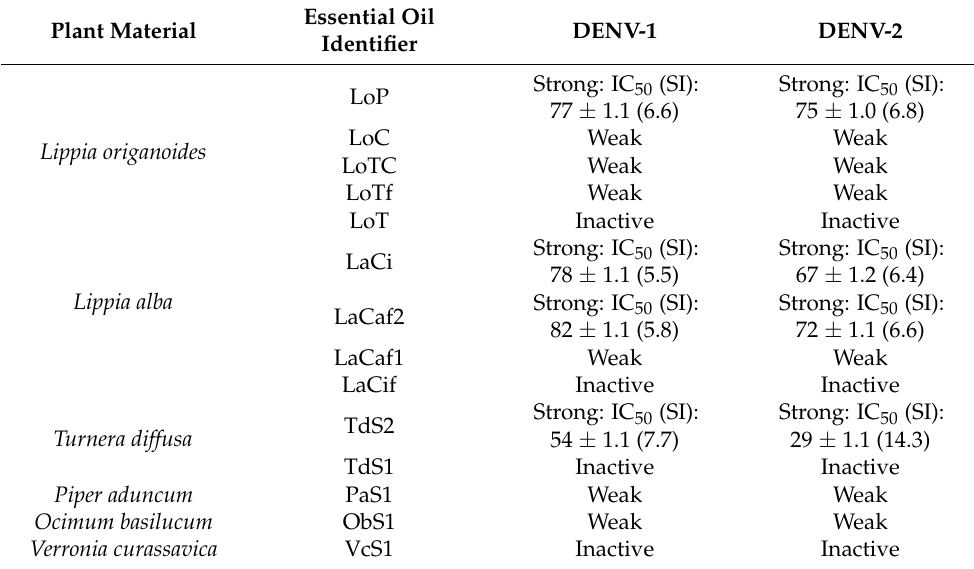
Table 3. The activity of the essential oils tested against dengue virus serotypes in the cytopathic effect (CPE) assay. Essential Oil DENV-1 DENV-2 Plant Material Identifier Strong: IC 50 (SI): Strong: IC 50 (SI): LoP 77 ± 1.1 (6.6) 75 ± 1.0 (6.8) LoC Weak Weak Lippia origanoides LoTC Weak Weak LoTf Weak Weak LoT Inactive Inactive Strong: IC 50 (SI): Strong: IC 50 (SI): LaCi 78 ± 1.1 (5.5) 67 ± 1.2 (6.4) Lippia alba Strong: IC 50 (SI): Strong: IC 50 (SI): LaCaf2 72 ± 1.1 (6.6) LaCaf1 Weak Weak LaCif Inactive Inactive Strong: IC 50 (SI): Strong: IC 50 (SI): TdS2 Turnera diffusa TdS1 Inactive Inactive Piper aduncum PaS1 Weak Weak Ocimum basilucum ObS1 Weak Weak Verronia curassavica VcS1 Inactive